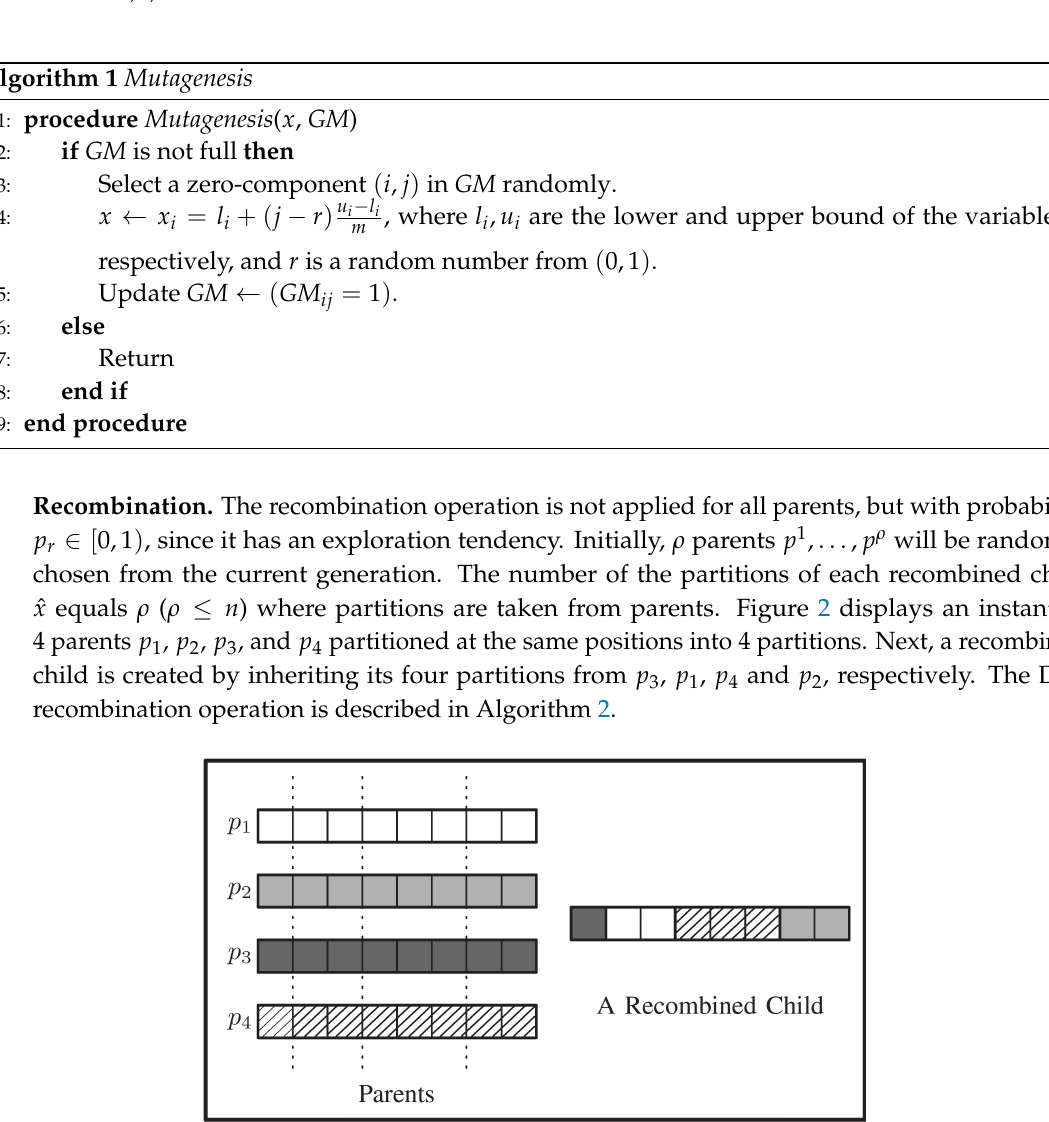
Figure 2. An example of the recombination